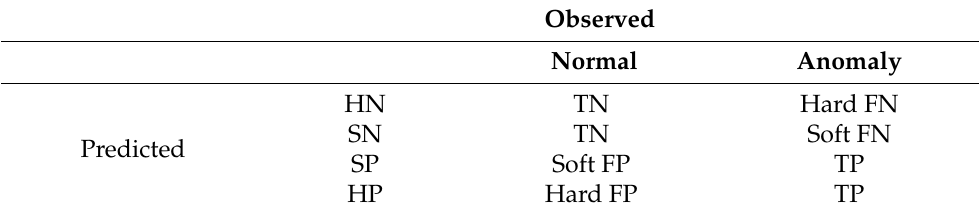
Table 12. Definition of hard and soft errors for evaluation of the modified predictions.